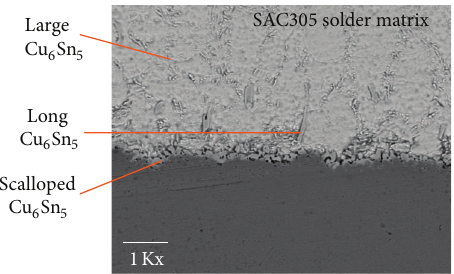
Figure 5: FESEM image of SAC305 solder joints with the Cu